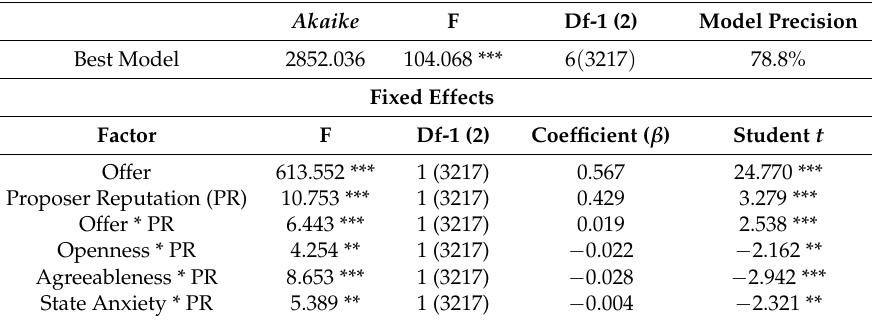
Table 5. Generalised Linear Mixed Models 2. Effects of Reputation and “Reputation Susceptibility” on the Acceptance